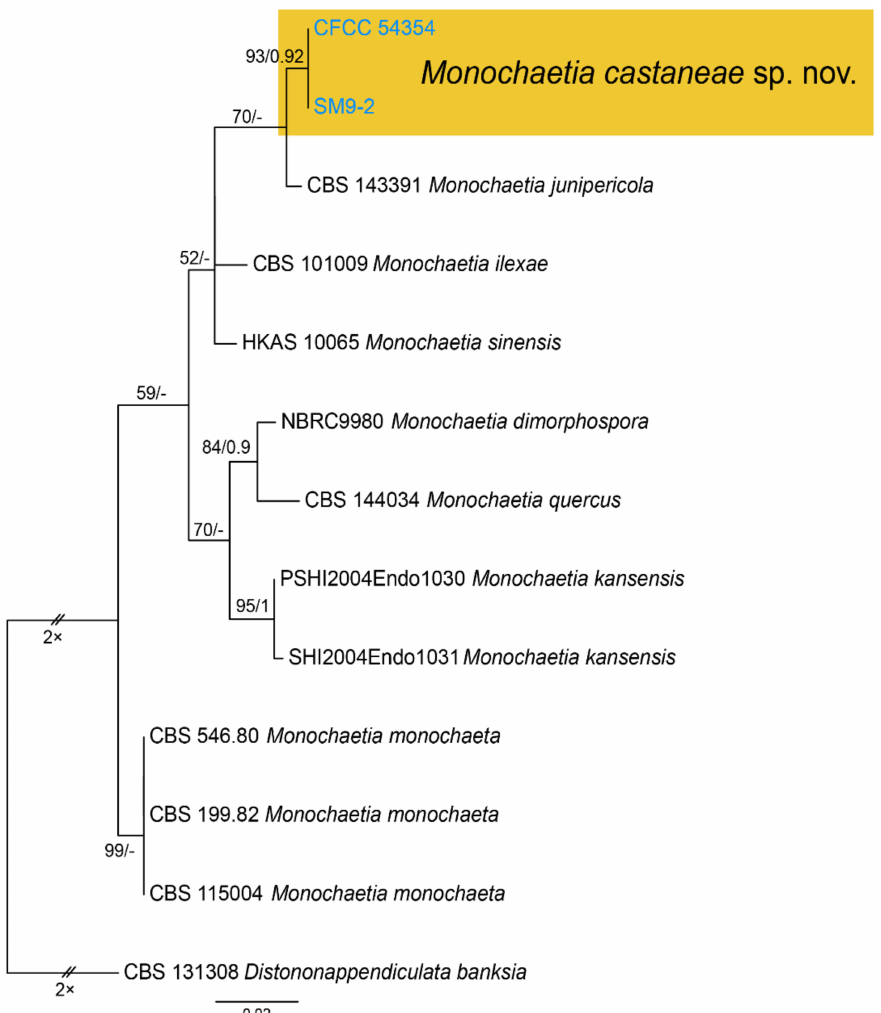
Figure 11. Phylogram generated from RAxML analysis based on combined ITS sequence data of Monochaeta isolates. The tree was rooted to Distononappendiculata banksia (CBS 131308). The scale bar indicates 0.02 nucleotide changes per site. Isolates from this study are highlighted. Isolates from this study are marked in blue, and the identified species is marked in